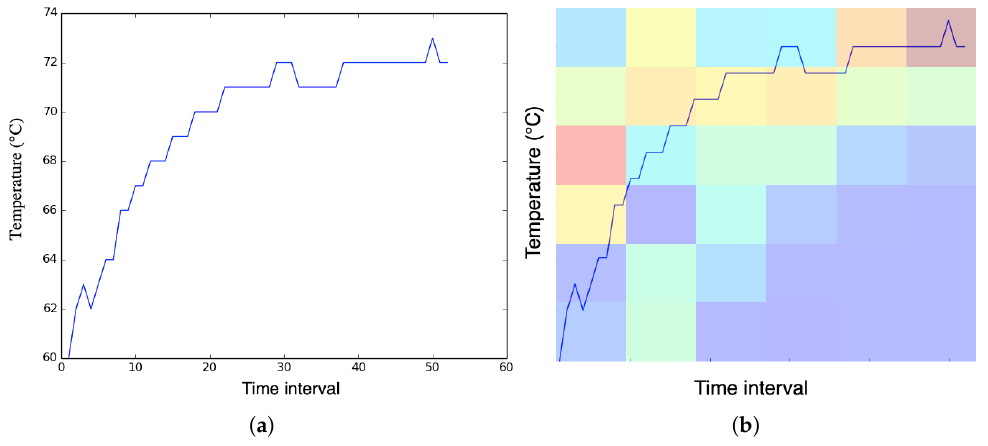
Figure 1. Focus area of ResNet network on a representative graph of password: